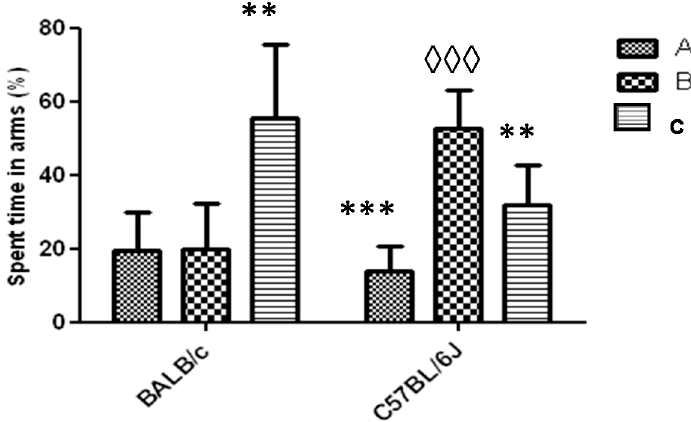
Figure 6. Response to Y-maze task (one arm blocked) for strains BALB/c and C57BL/6J mice. The letters A, B and C identify each arm during the task (B-arm blocked). Data shows mean ± standard deviations for groups in relation to the spent time in each arm. * Represents significant differences with respect to B arm for each strain. ◊ Represents significant differences between the spent times in the blocked arm (B) between the two strains. A one-way ANOVA was used and the Tukey post hoc test for p ˂ 0.05.